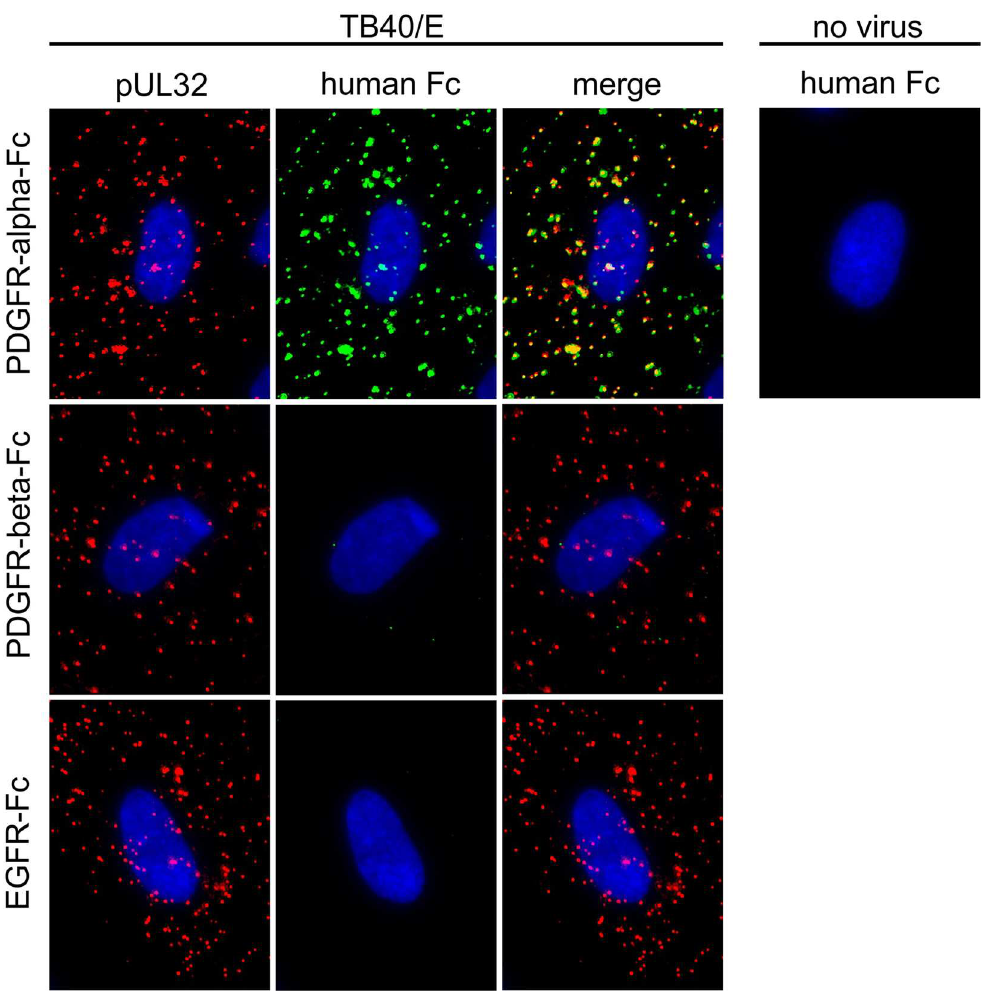
Fig 4. Binding of soluble growth factor receptor-Fc chimerasto HCMV particles. Virus preparations of strain TB40/E were pretreatedfor two hours with 500 ng/ml PDGFR-alpha-Fc, PDGFR-beta-Fc or EGFR-Fc and then incubatedwith fibroblastsfor 90 min on ice. Cells were fixed and stained for the viral structural protein pUL32(red) and for the Fc-fusion part (green). Nuclei were counterstained with DAPI.